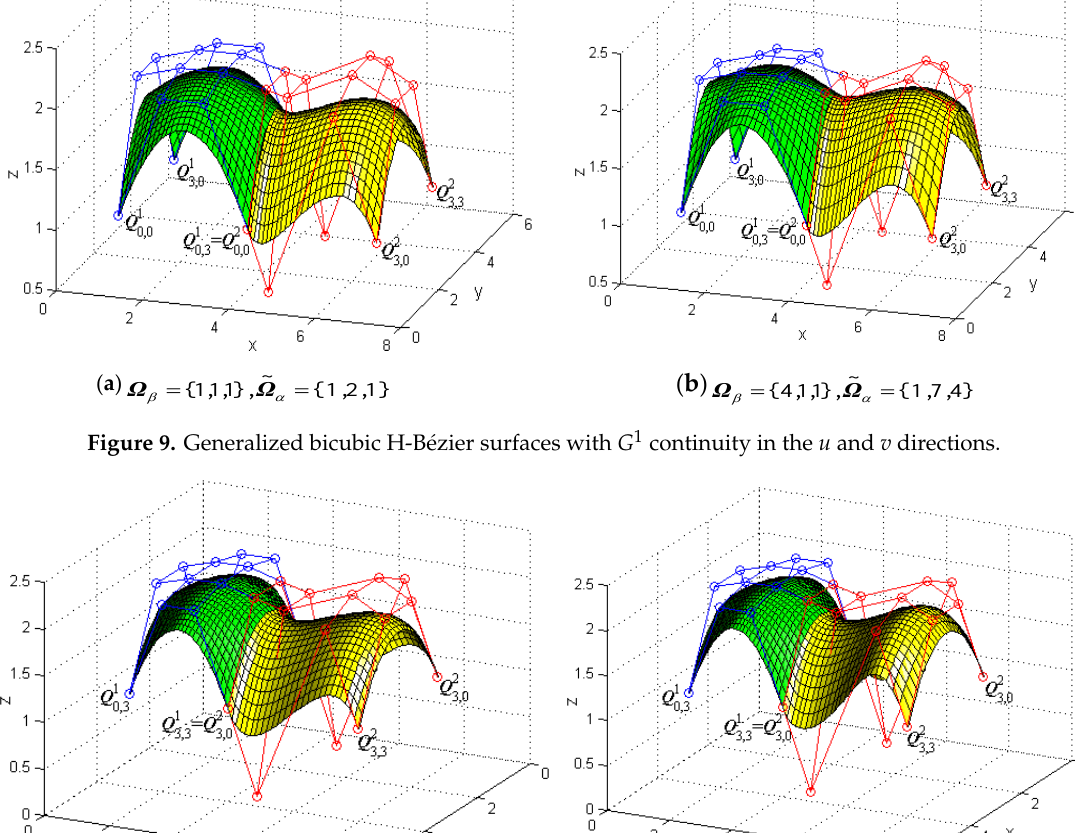
Figure 9. Generalized bicubic H-Bézier surfaces with G 1 continuity in the u and v directions.